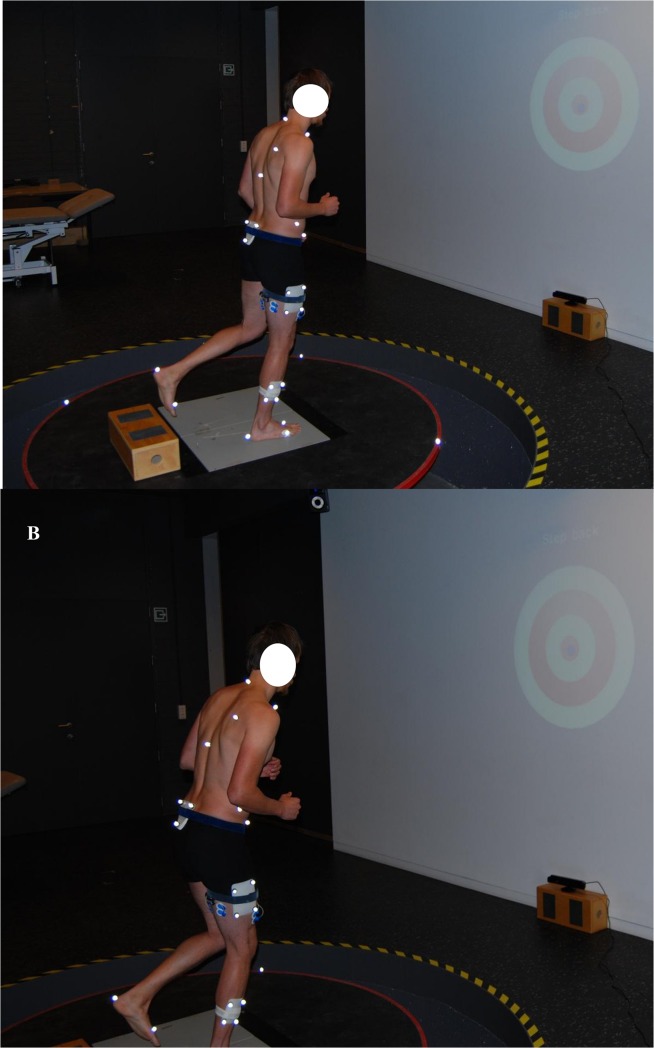
Visualisation of single-leg stepping down-task.A: Participant who performed the stepping down task with a more erect knee joint. B: Participant who performed the stepping down task in a more flexed pattern (more knee and hip joint flexion).